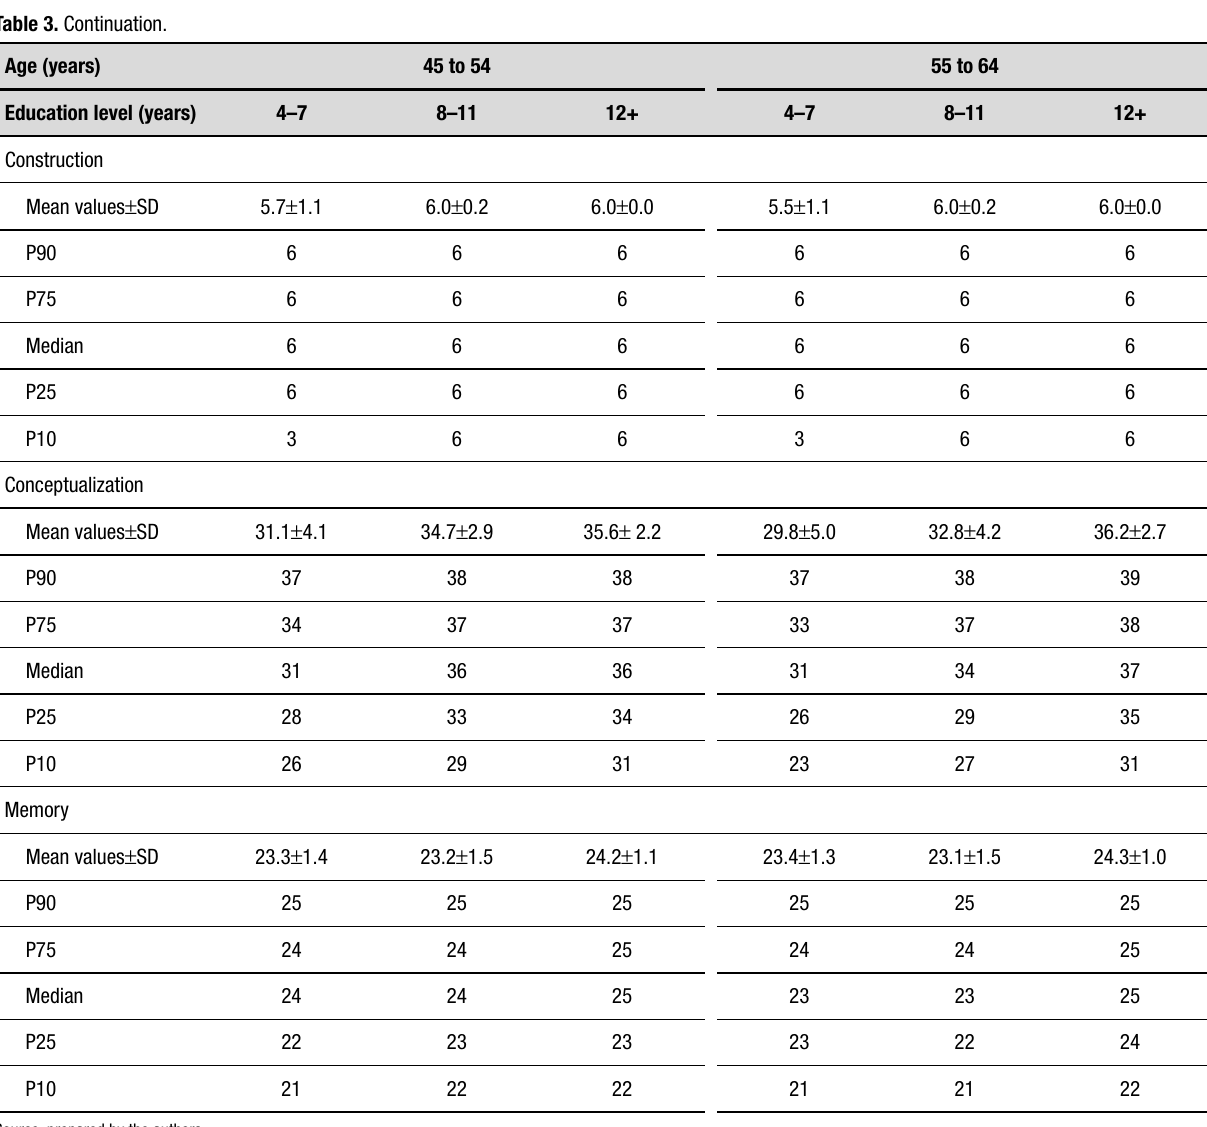
Table 3. Continuation.